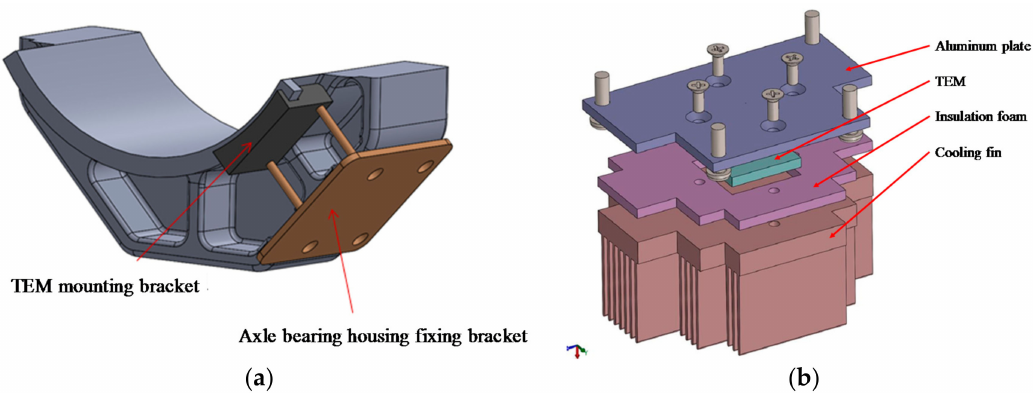
Figure 9. Design of ( a ) TEM mounting and fixing bracket and ( b ) cooling fin for applying on rolling